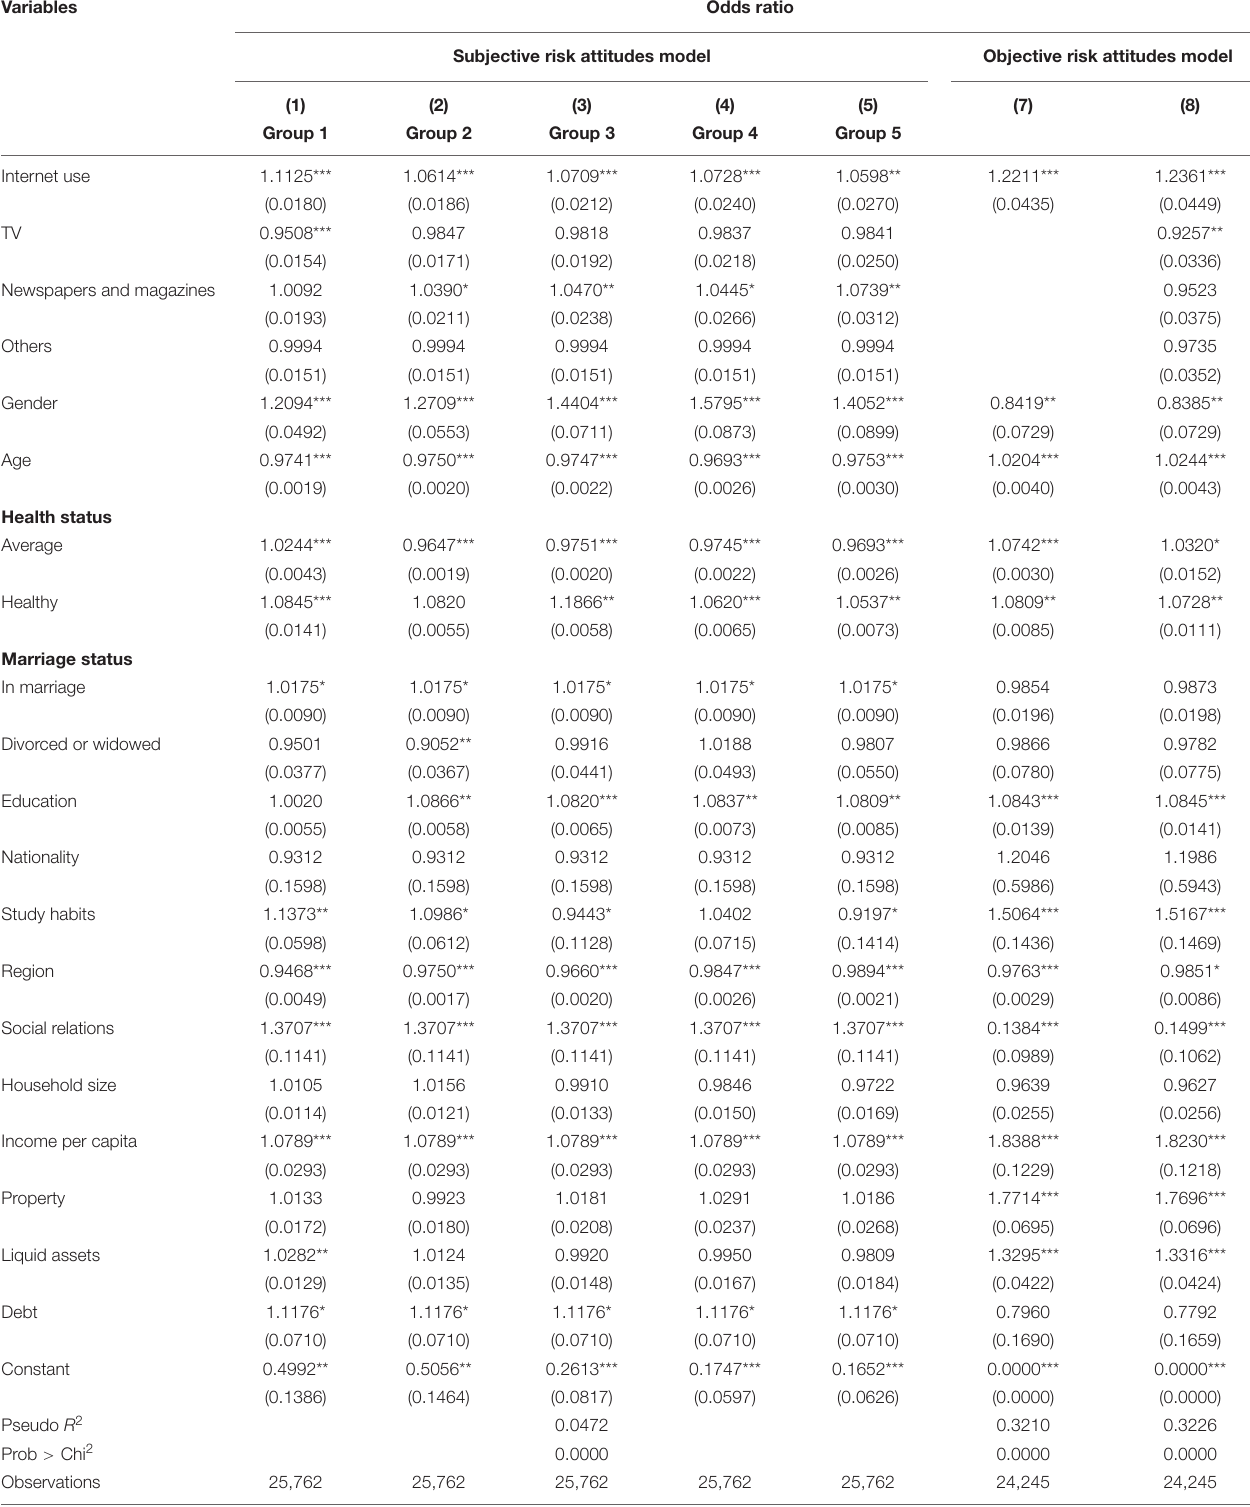
TABLE 2 | Estimates of the impact of internet use on residents’ risk